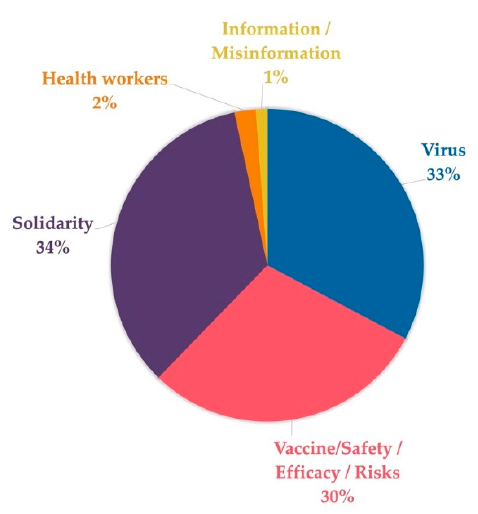
Figure 2. Weight (%) of the major themes in the messages.